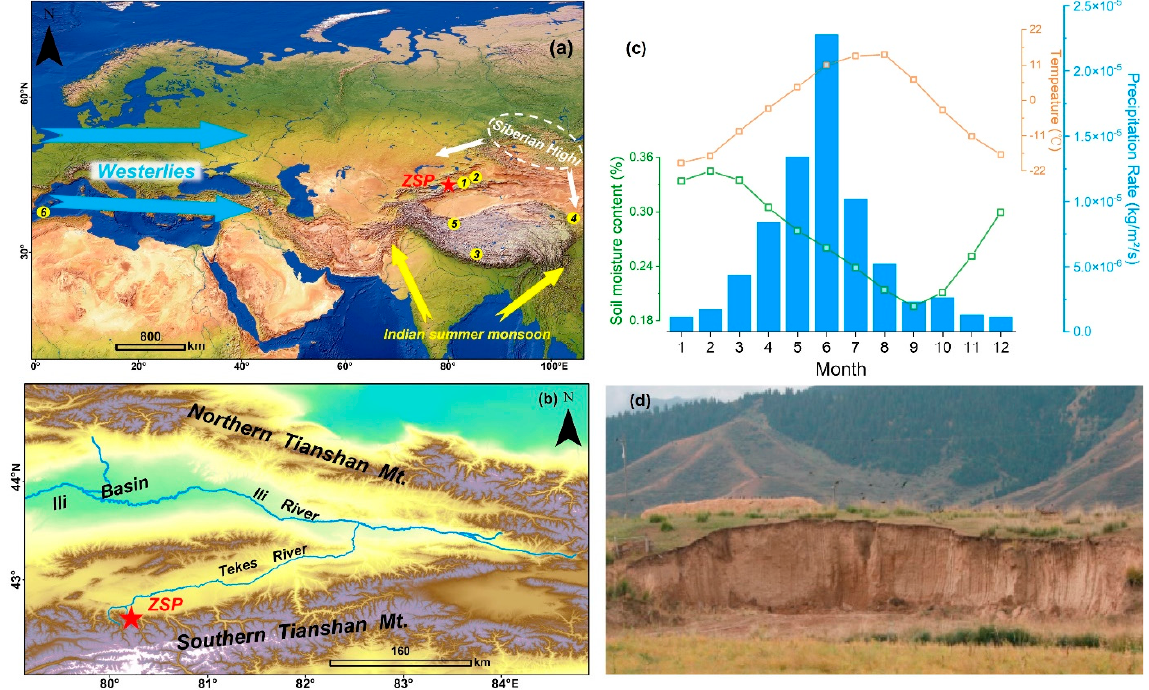
Figure 1. ( a ) Locations of the involved study site with atmosphere circulations. ZSP: Zhaosu